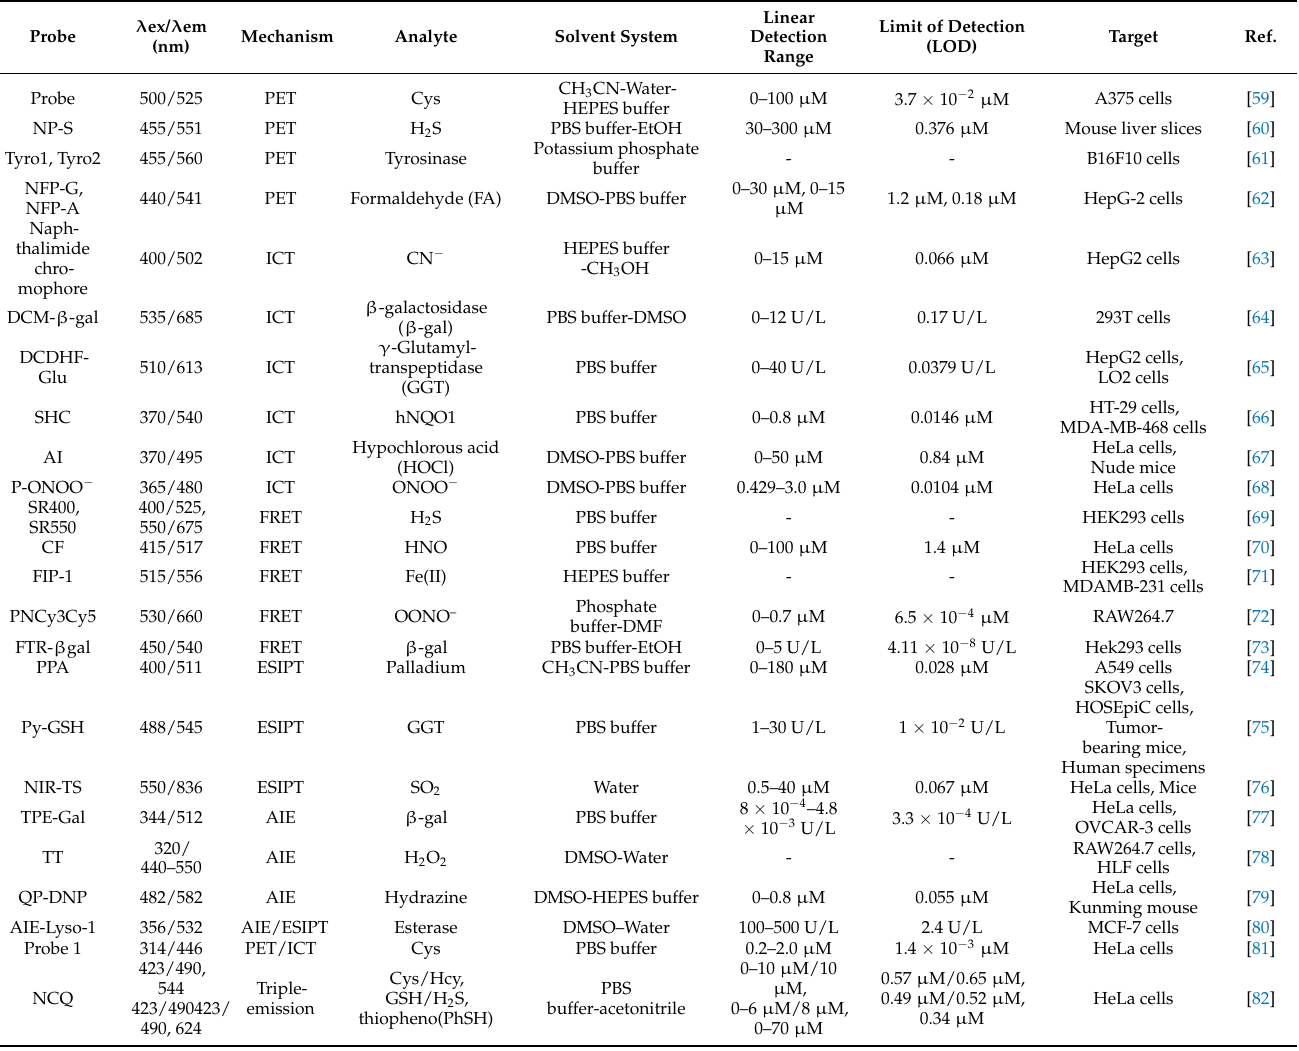
Table 1. Fluorescence characteristic, recognition mechanisms, and applications of